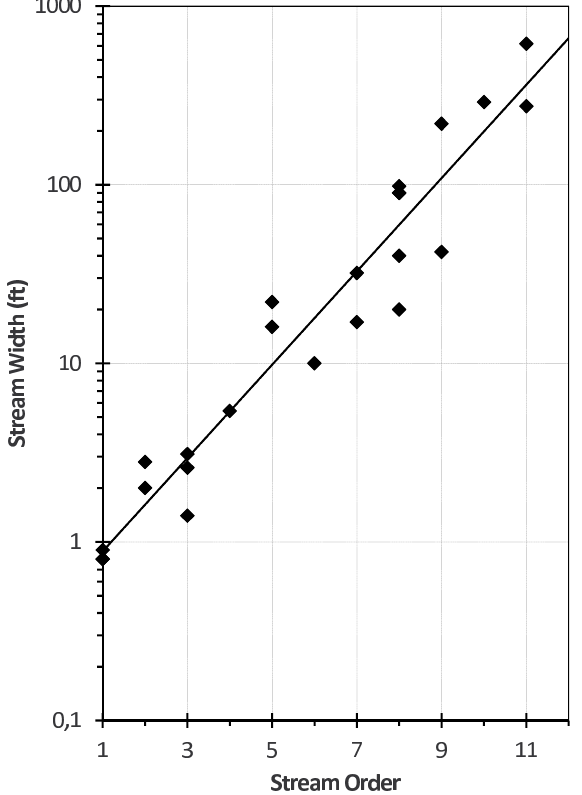
Figure 2. Reproduction of the original figure of Leopold and Miller (1956, Fig. 19, p. 23), showing the relation of stream width to stream order in